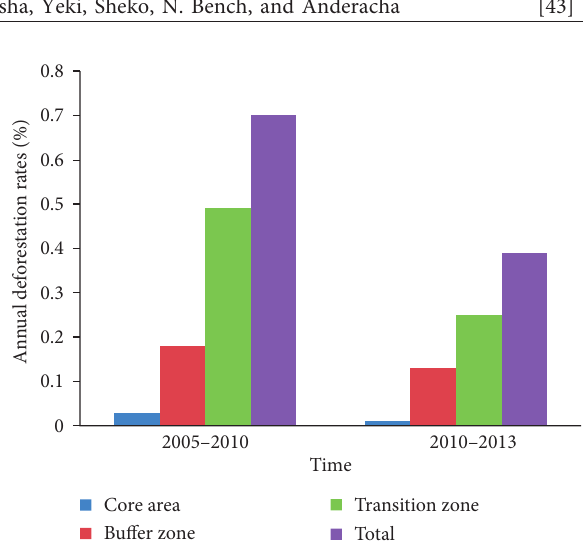
Figure 4: Annual deforestation rate before and after establish- ments of Yayo biosphere reserves. Source: